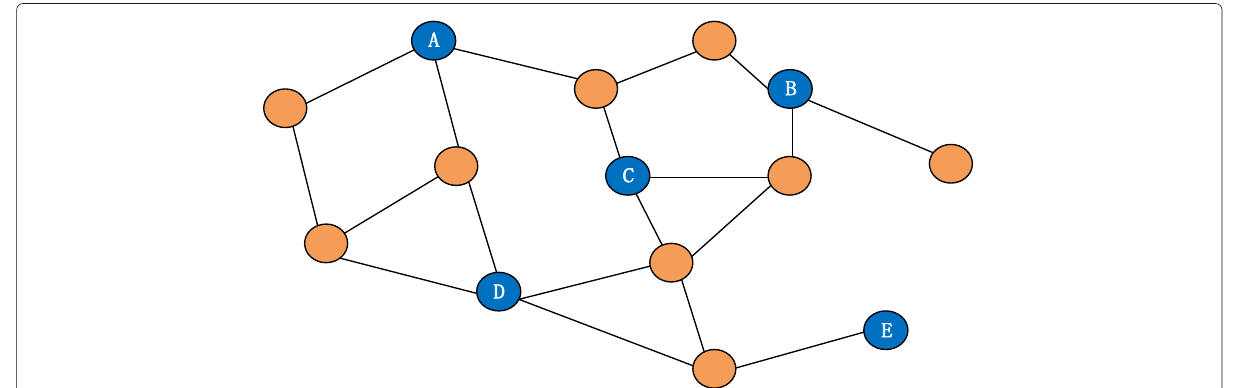
Fig. 1 DV-Hop nodes distribution shows the distribution information of sensor nodes in WSN